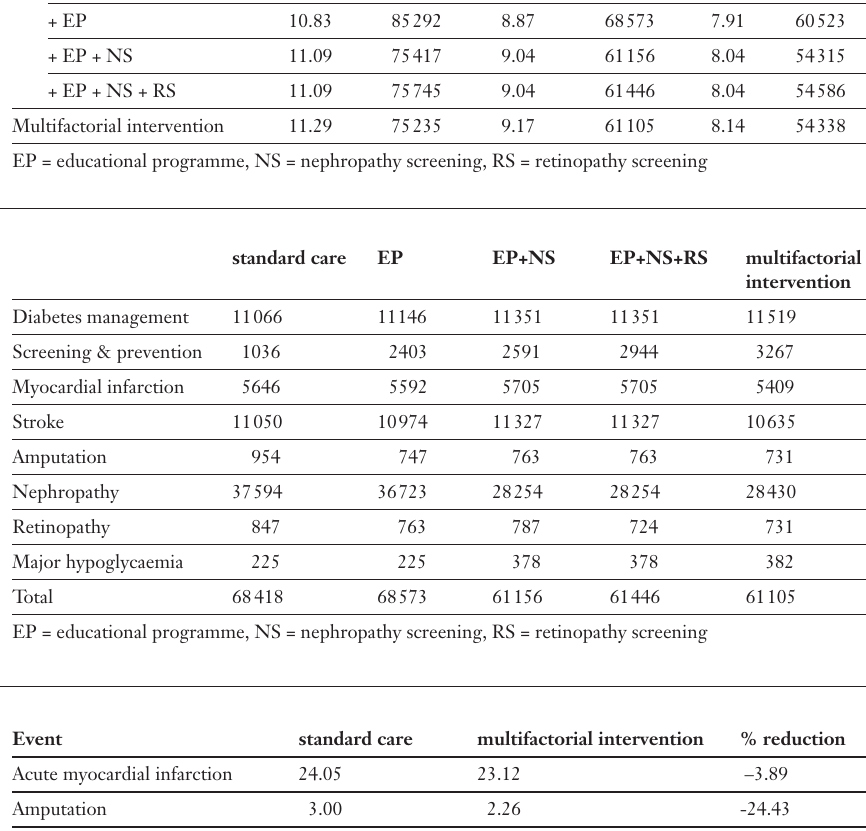
Cumulative event rates (%) of diabetic complications per lifetime in type 2 dia- betes patients with standard care and with multifactorial in-